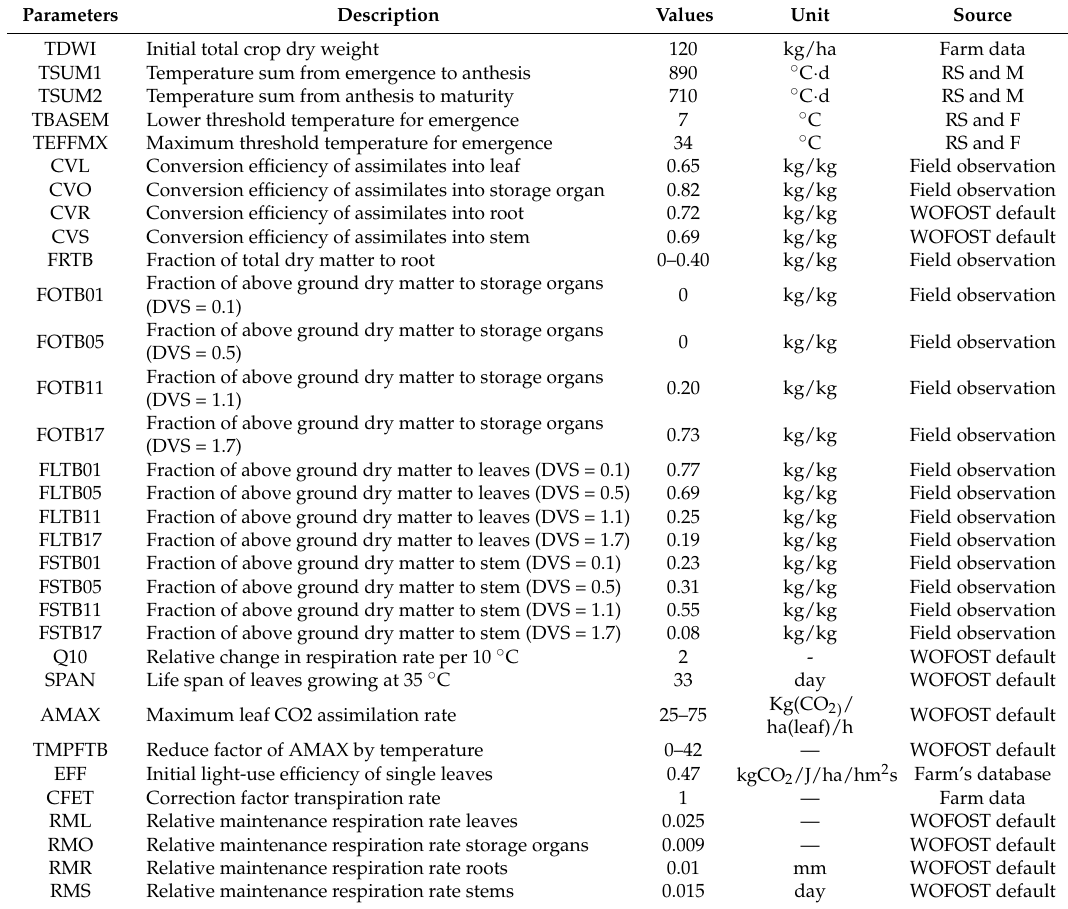
Table 4. Input crop parameters of the WOFOST